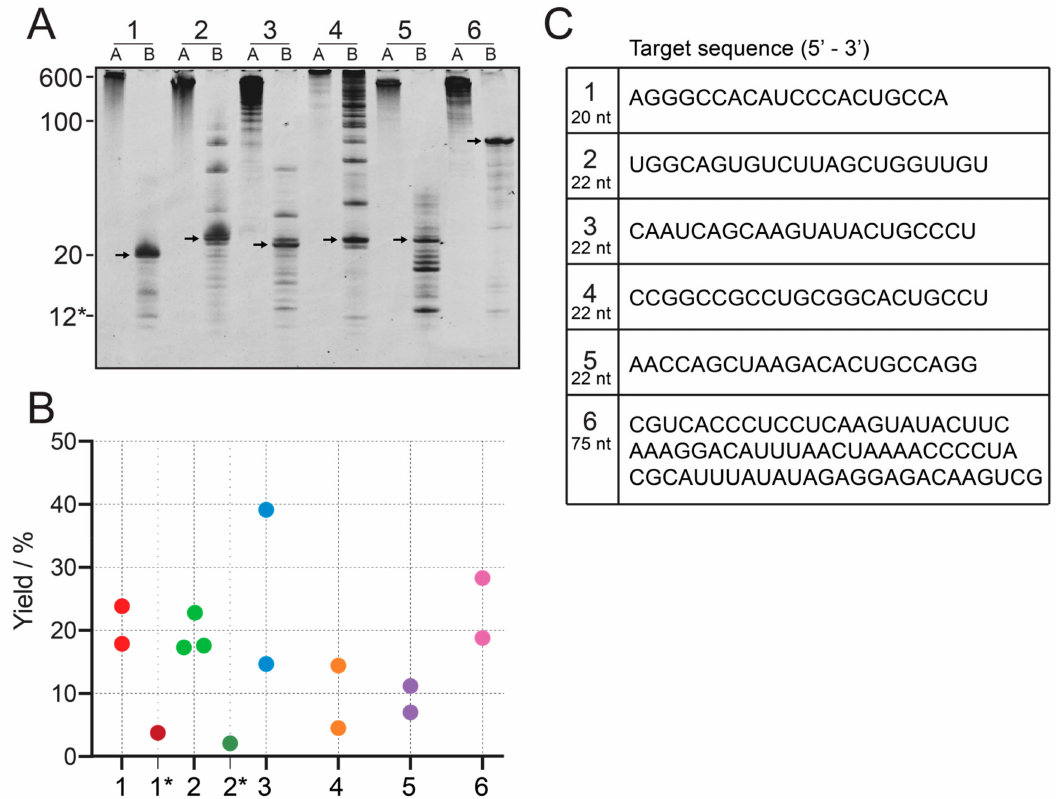
Figure 3. Yield comparison between 6 di ff erent constructs. ( A ): IVT (lanes A) and cleaved tandem transcription (lanes B) for six constructs. 1: 20 nt, 2–5: 22 nt, 6: 75 nt. To allow comparison